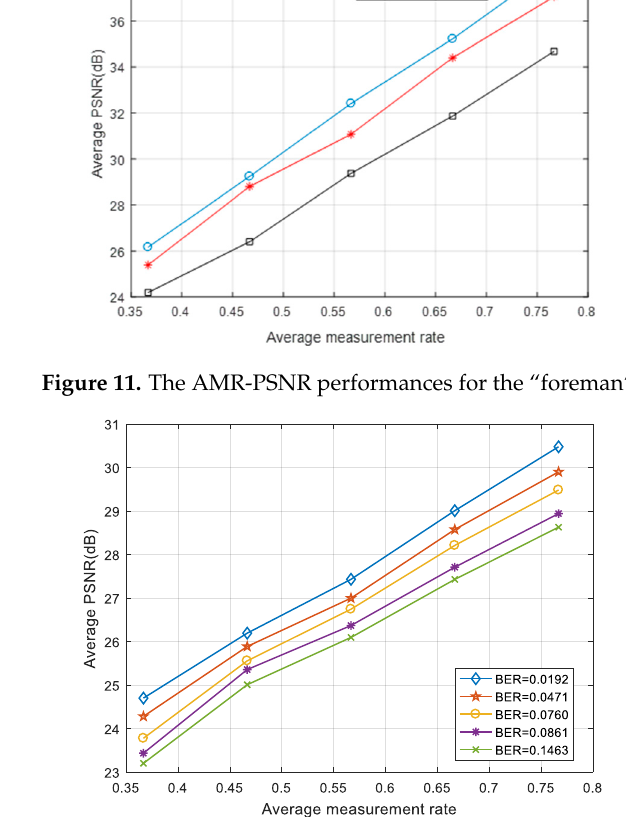
Figure 12. The AMR-PSNR performances for th e “ coastguard ”.